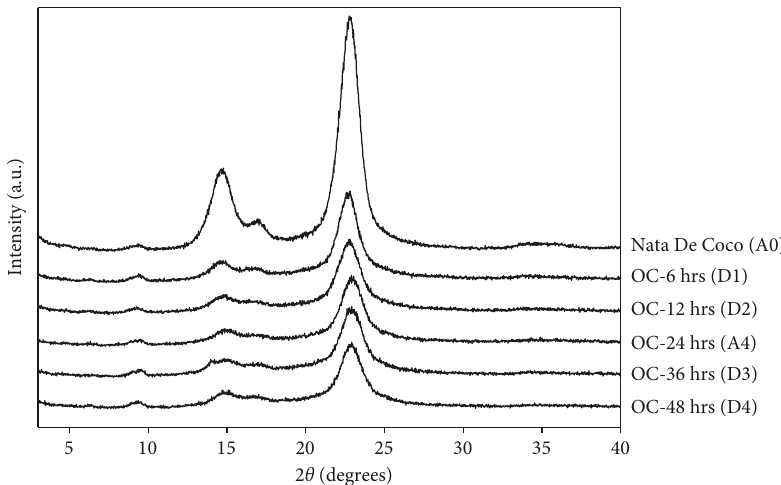
Figure 11: X-ray diffraction patterns of DNDC (A0) and the OC